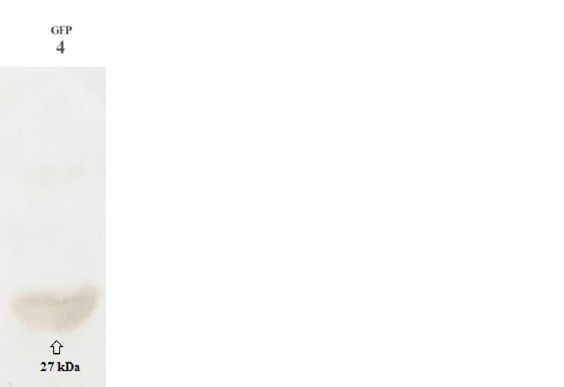
Figure 3. Evaluation of GFP ( B ), L2-GFP ( C ) and L1-GFP ( D ) DNA delivery into HEK-293T non-cancerous cells using TurboFect. Transfection efficiency was monitored by fluorescent microscopy (above) and flow cytometry (bottom) at 48 h post-transfection as compared to the negative control ( A ).